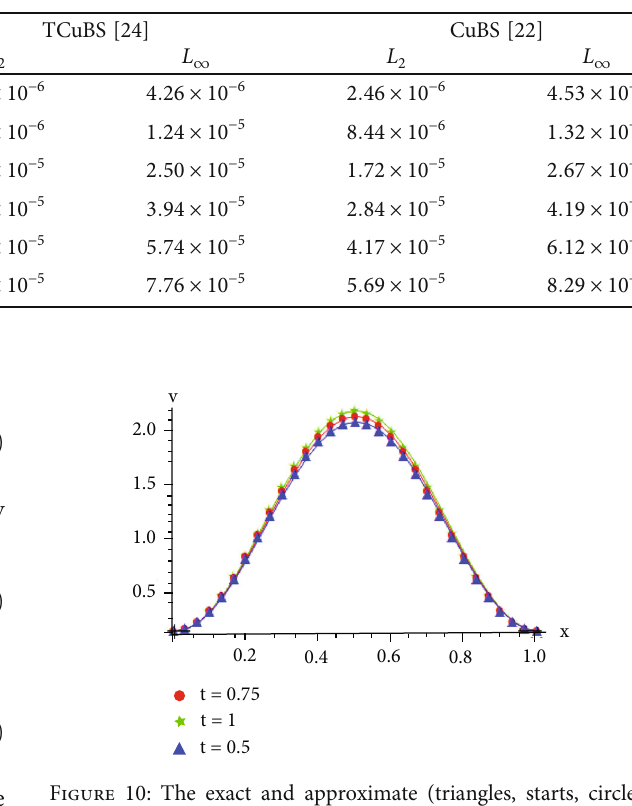
Table 4: Error comparison for Example 8 when γ = 1/4 , N = 50 , and Δ t = 10 − 4 .